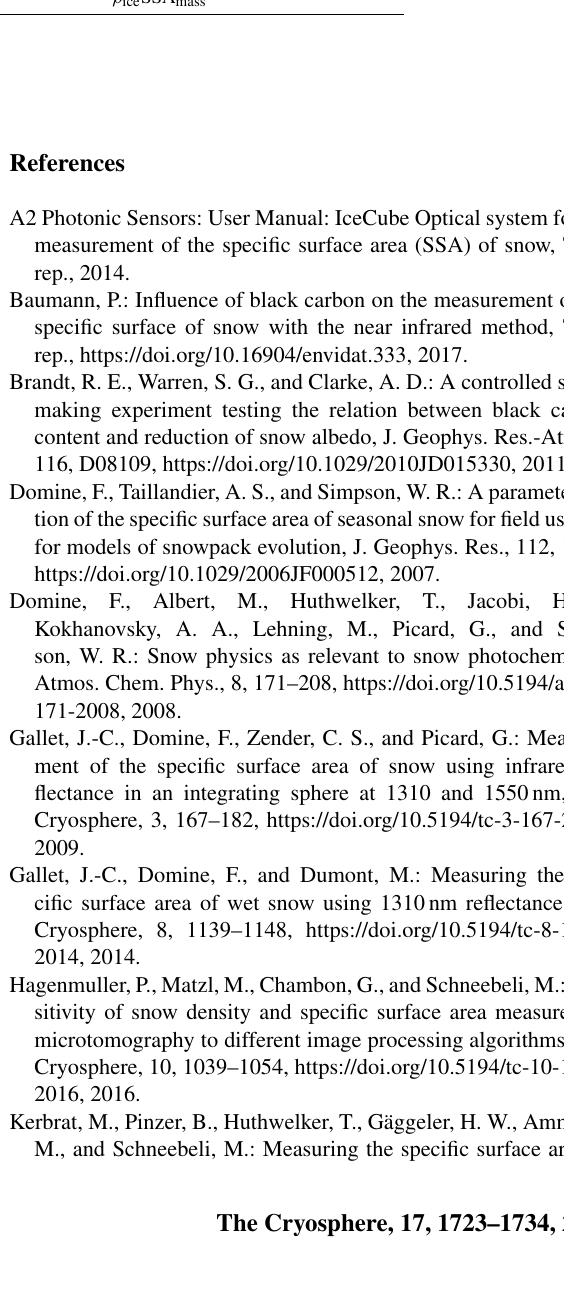
Table A2. The equations used in this paper, including parameters and units.